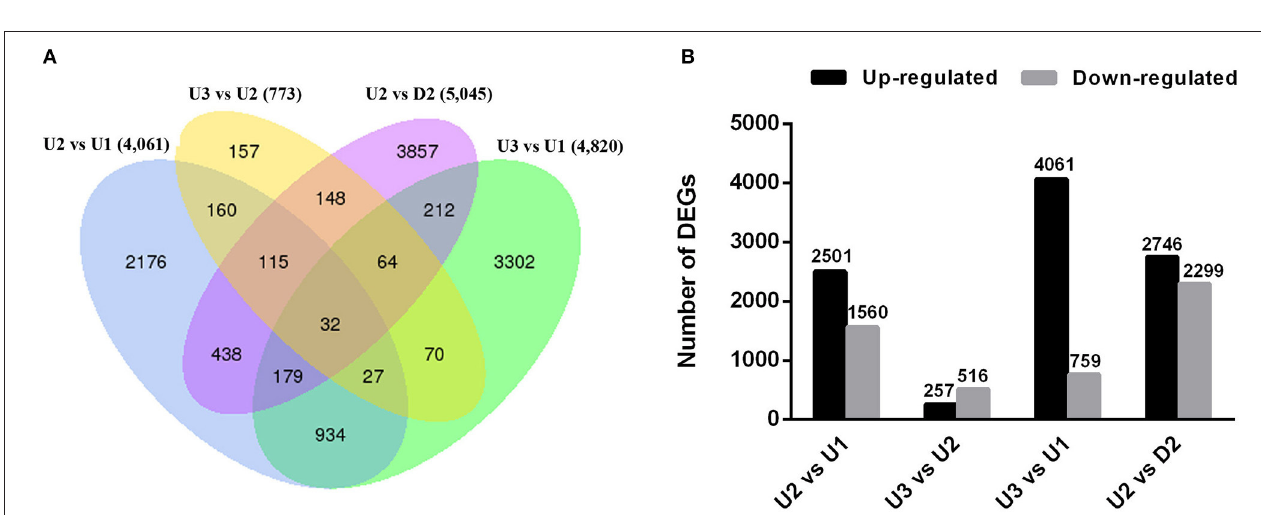
FIGURE 3 | Overview of numbers of DEGs in pairwise comparisons. (A) Venn diagram of DEGs among the four comparisons performed (U2 vs. U1, U3 vs. U2, U2 vs. D2 and U3 vs. U1). (B) Histogram showing the number of DEGs that were up- or down-regulated between different libraries. The black columns indicate up-regulated DEGs, and the gray columns represent down-regulated DEGs in the four pairwise